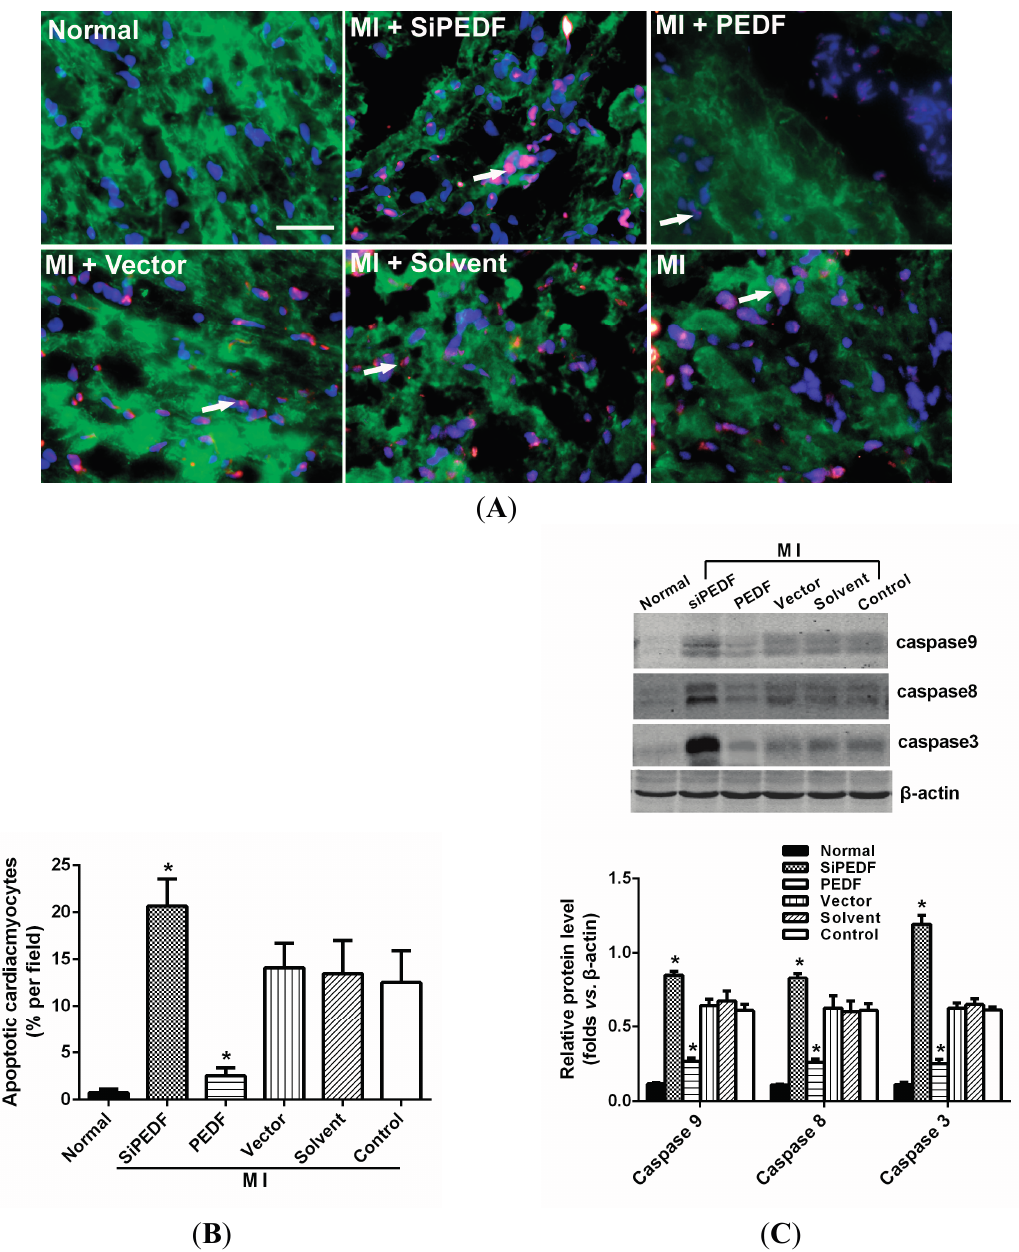
Figure 2. Cardiomyocyte apoptosis assay in vivo . ( A ) Representative images of TUNEL staining of cardiomyocyte apoptosis (white arrow). Cardiomyocyte apoptosis was measured by TUNEL staining; cardiomyocytes were identified using α -sarcomeric actinin antibodies ( α -sa). TUNEL staining for cardiomyocyte apoptosis (red), Hoechst for nuclear staining (blue) and α -sa for cardiomyocytes (green) in the border zone of the infarcted left ventricle (LV) at four weeks after AMI (Scale bar = 20 μ m); ( B ) Bar graphs indicate quantitative analysis of cardiomyocyte apoptosis; and ( C ) Western blot determination for protein expression of cleaved caspases-8, -9, and -3 and FasL. Data are expressed as the mean ± SD ( n = 6). * p < 0.05 vs. the control